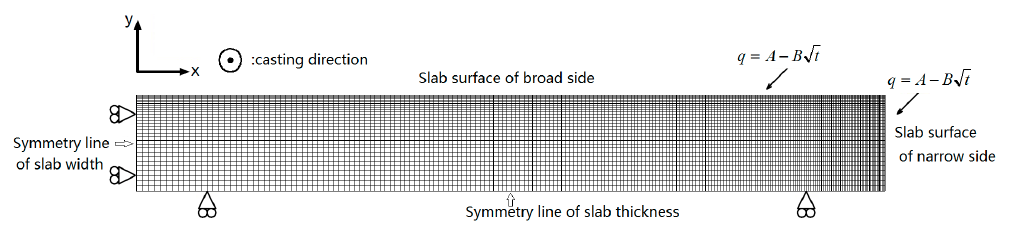
Figure 1. The mesh details of the model.